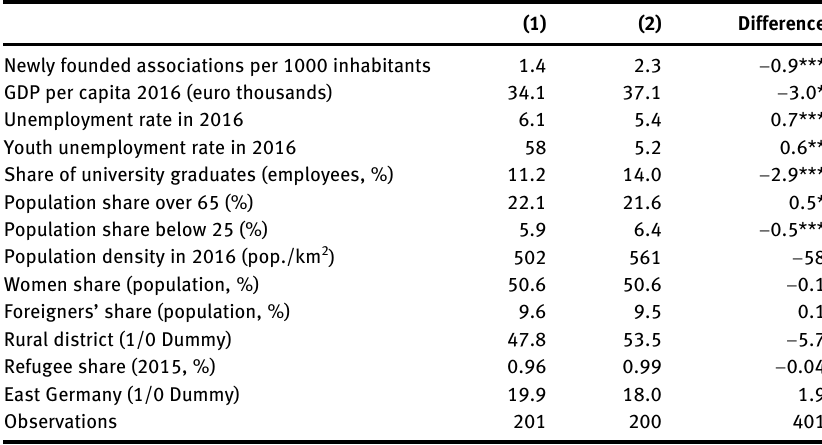
Table  : Comparison of counties with association growth above and below the